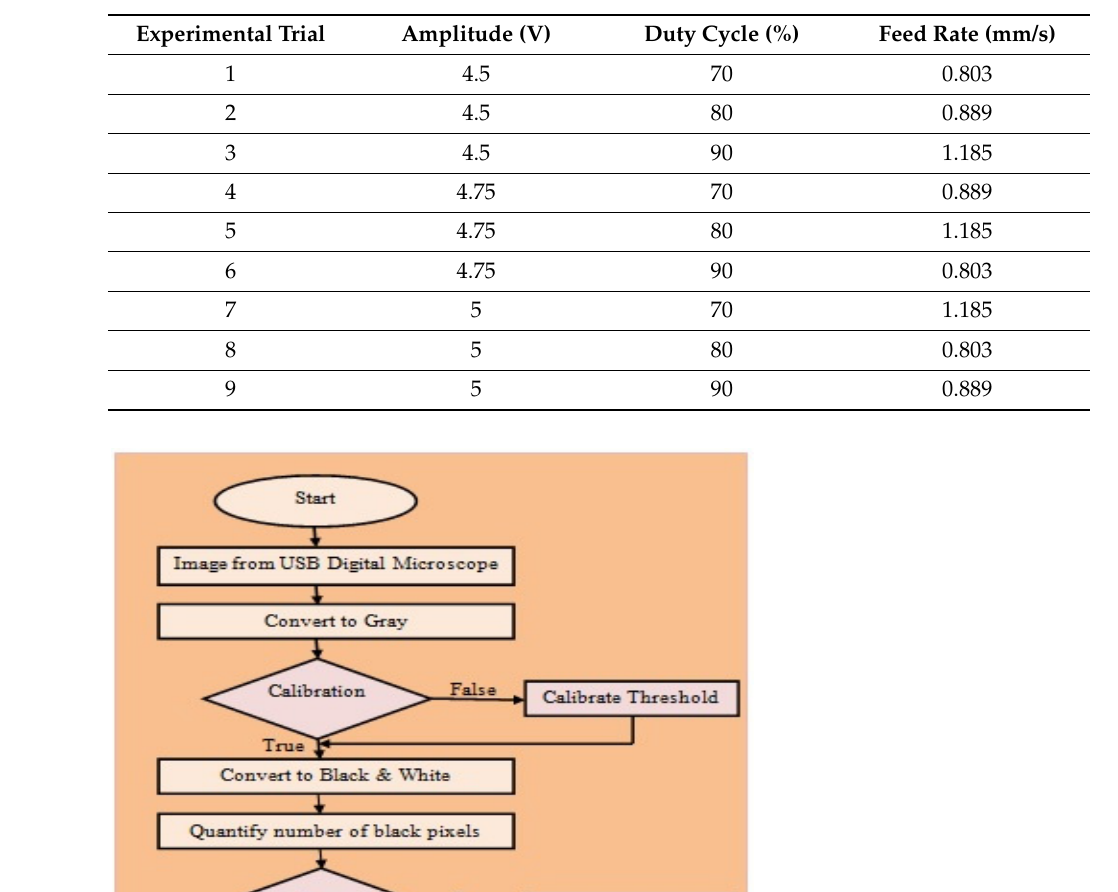
Table 2. Experimental trial in the proposed study.